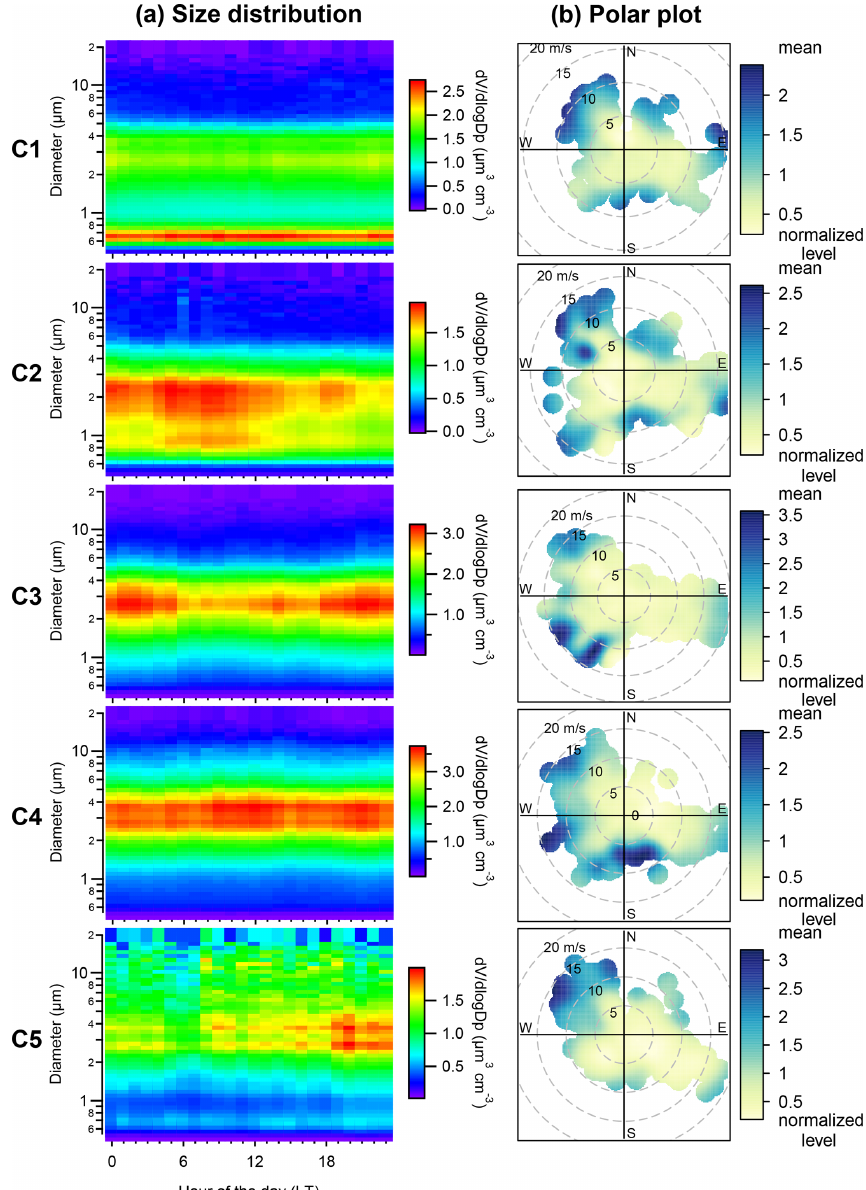
Figure 3. (a) Diurnal variation of the mean of the aerosol volume size distribution and (b) polar plots of total volume concentration for the five aerosol clusters. Polar plots show that the average concentrations vary by wind speed and wind direction. The color scale of the polar plot is the average concentration level normalized by dividing by the mean value from each